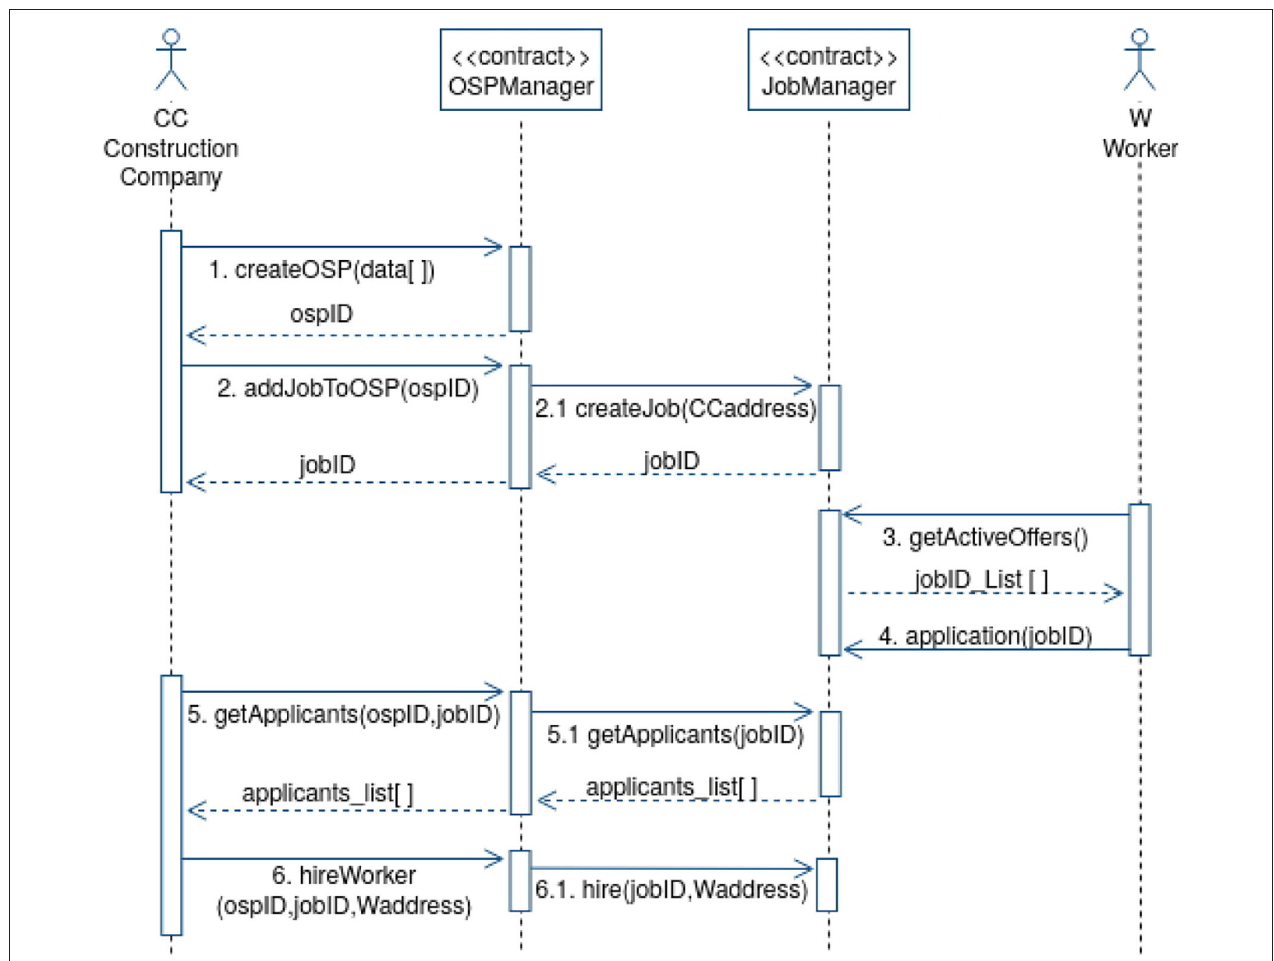
FIGURE 8 | Simplified Sequence Diagram of main interactions between the actors “Construction company” and “Worker” with the smart contracts “OSPManager” and “JobManager” during the hiring